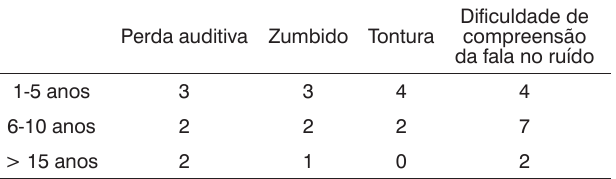
Tabela 4. Queixas auditivas apresentadas pelos ex-usuários, segundo o tempo de uso de drogas.